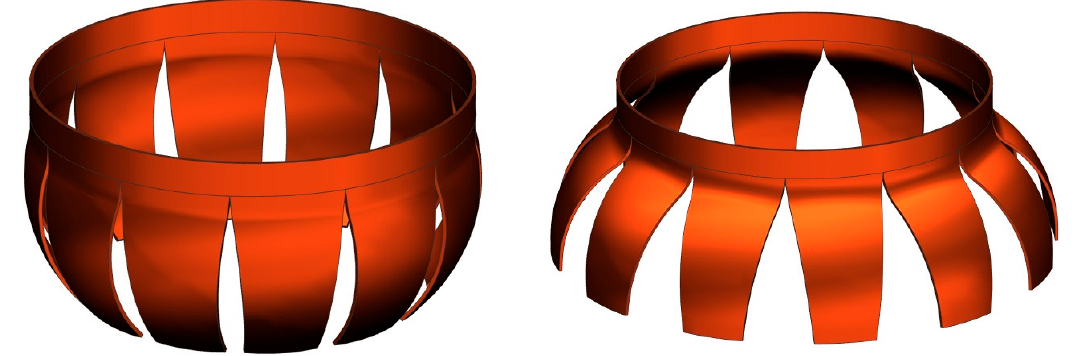
Figure 3. Schematic diagram of core keepers close ( left ) and open ( right ).